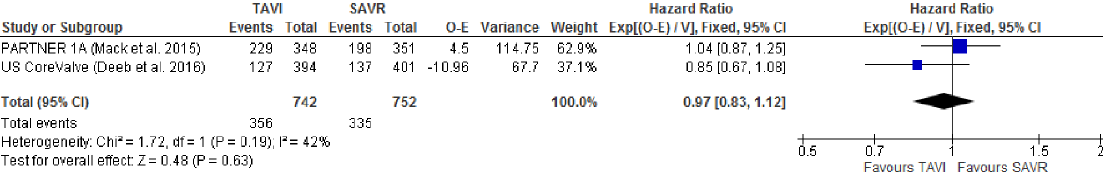
Fig 2. Hazard ratio of all-cause mortality up to 5 years (in patients surgically operable at a high risk).